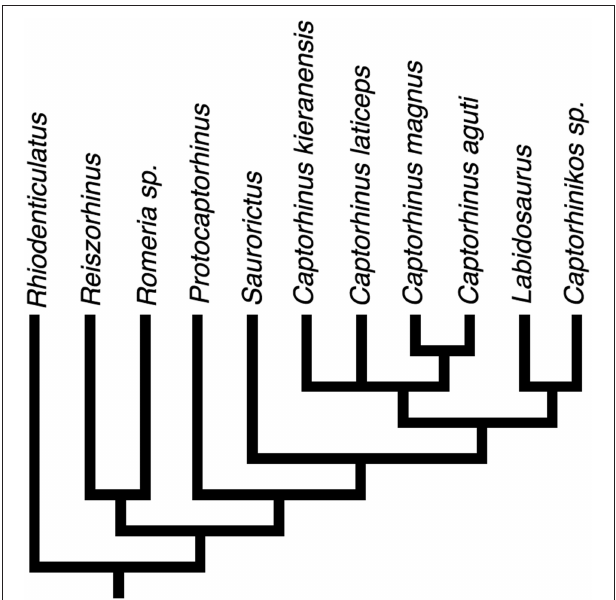
FIGURE 15 | Overview of relationships for representative captorhinids. Note that this phylogeny does not reflect a formal analysis but is included simply as a general overview. For specific character diagnostics please refer to Modesto et al.